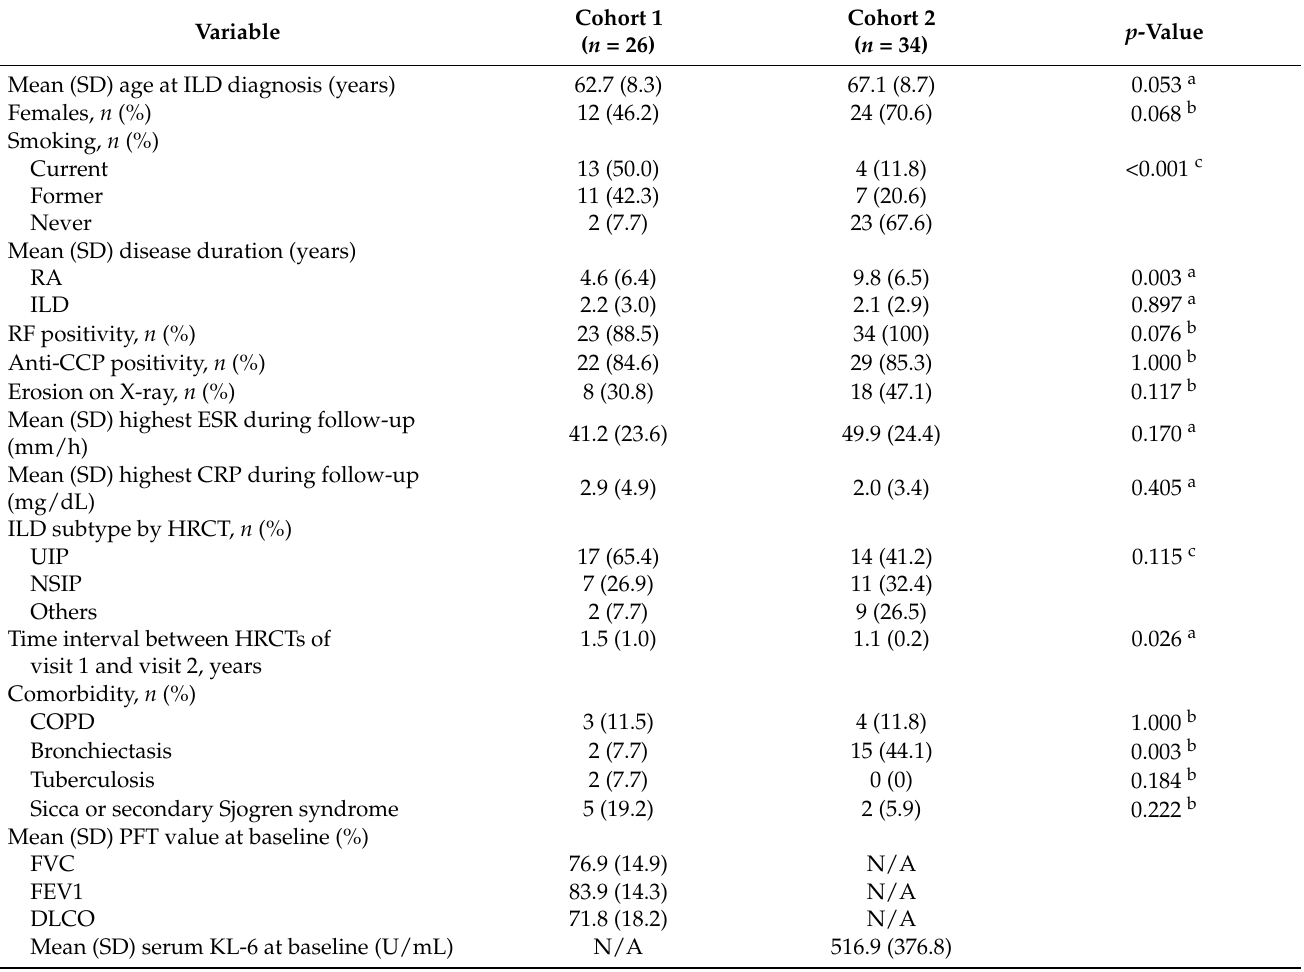
Table 1. Clinical characteristics of the patients with rheumatoid arthritis-associated interstitial lung disease.